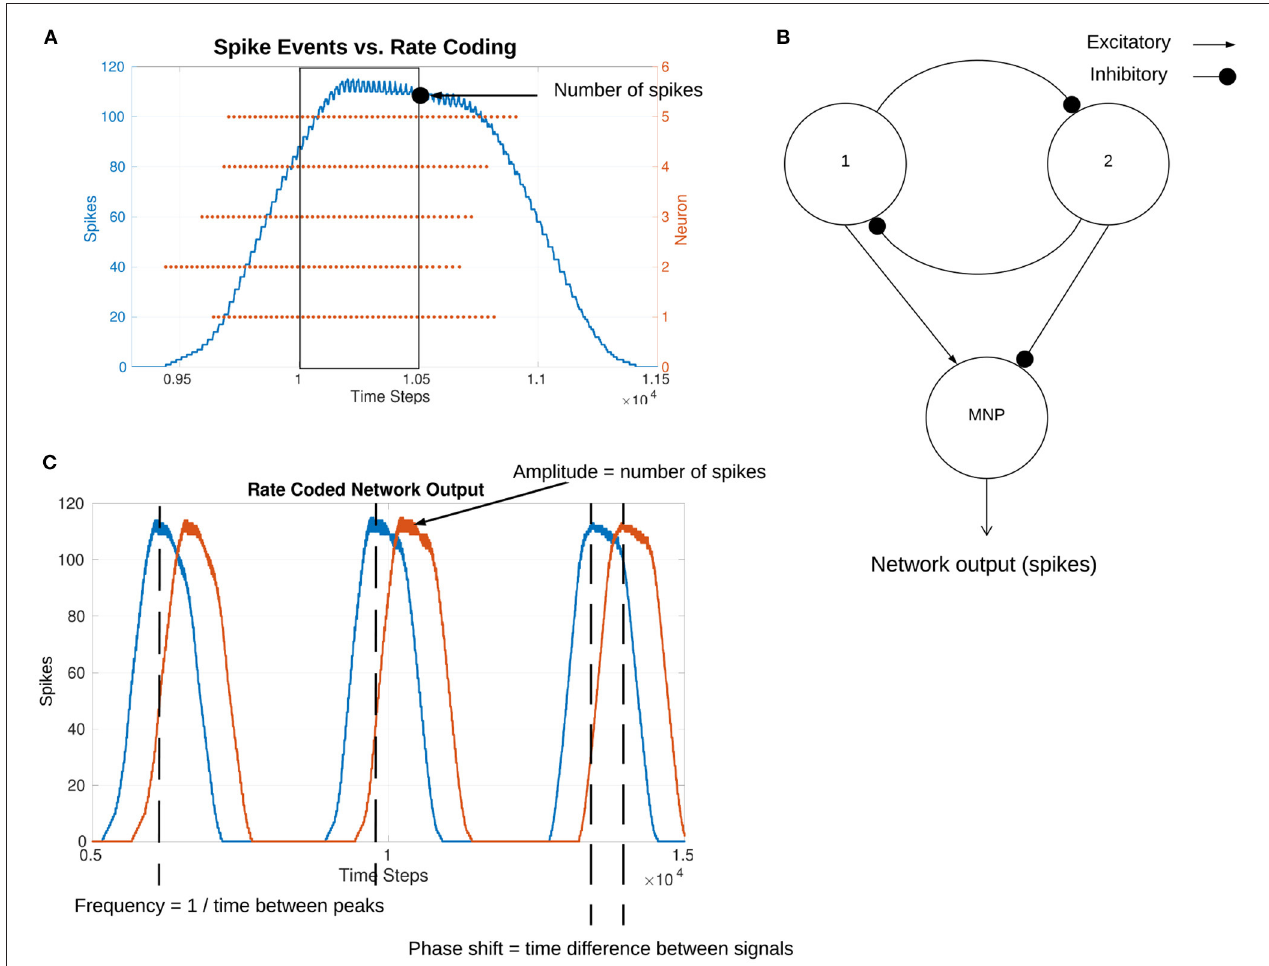
FIGURE 2 | (A) Illustration of how spikes are converted to analog values. The spike events for all neurons within a time window are counted. This value is used as the analog output value of the network. (B) Block diagram of the sCPG network. Neuron populations 1 and 2 create the spiking oscillator, sending spikes to the MNP. The output spikes from the MNP are considered the network output. (C) Visualization of the meaning of network output characteristics amplitude, frequency, and phase by use of two sample